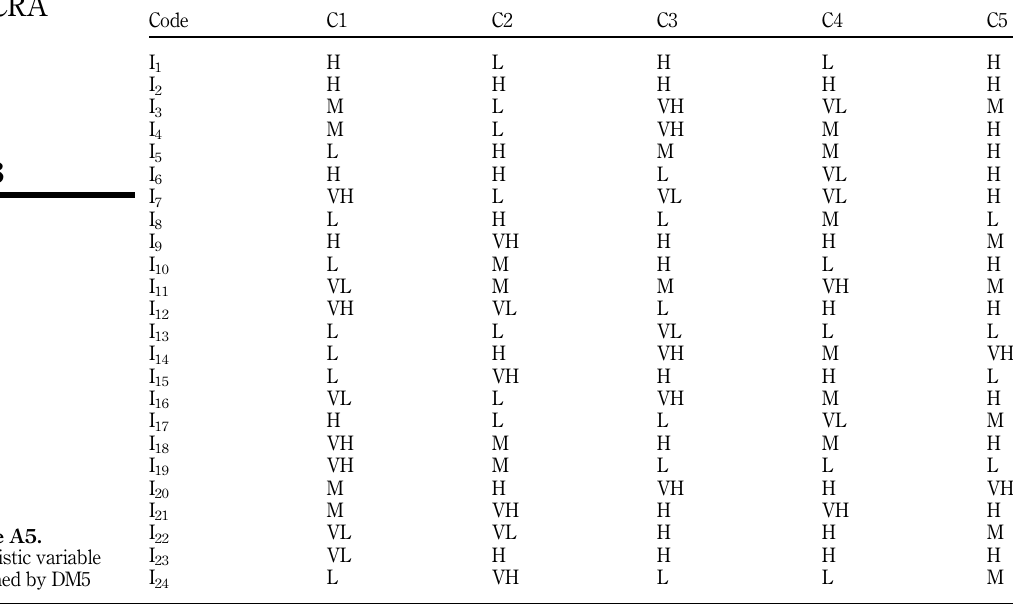
Table A5. Linguistic variable assigned by